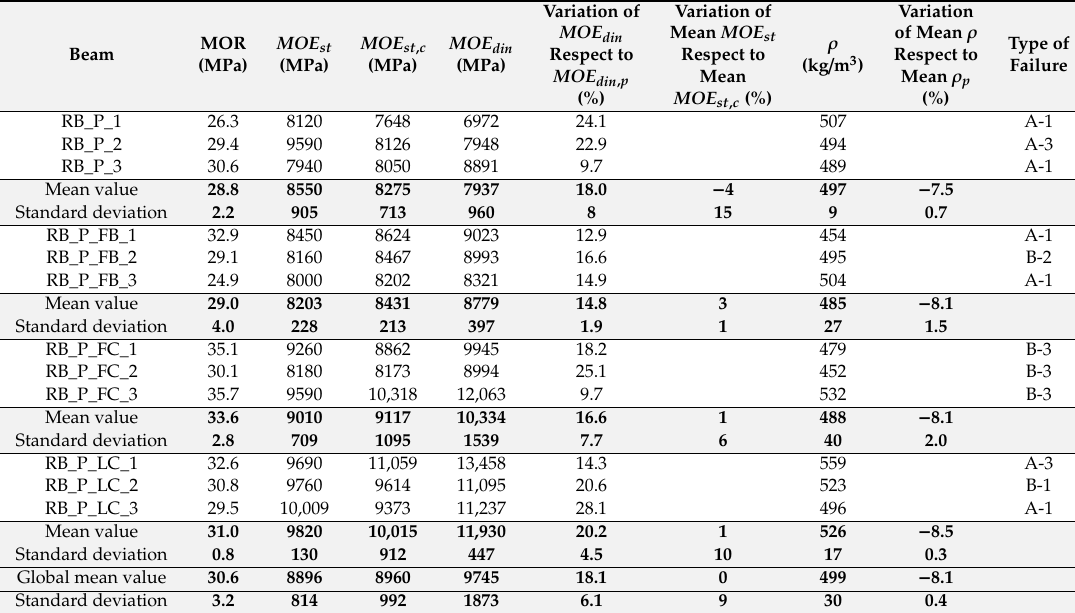
Table 3. Mechanical results for the 12 tested